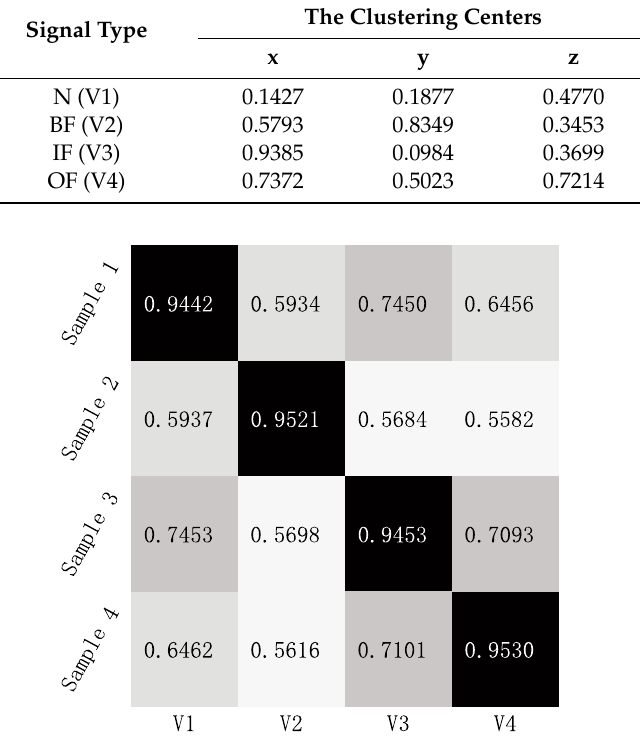
Table 4. GG clustering index using permutation entropy. CE: classification entropy, EMD: empirical mode decomposition, EEMD: ensemble empirical mode decomposition, MEEMD: modified ensemble empirical mode decomposition, PC: partition coefficients, XB: Xie and Beni’s index. Types of Entropy ( b ) Figure 7. ( a ) The GG clustering contour for EMD. ( b ) The GG clustering contour for MEEMD. From Figures 5 and 7, we can draw the following conclusions. (1) The clustering centers of four types of data vary over different signal decomposition methods, and there is an aliasing phenomenon with decomposition based on EMD and MEEMD. (2) The compactness of GG clustering results with EEMD is better than that of EMD and MEEMD. According to Table 4, the index PC of the cluster analysis with EEMD is 1.0000, which is larger than EMD (0.9927) and MEEMD (0.9783). The index CE and XB with EMD and EEMD is NaN (a number approaching zero in MATLAB). It means that